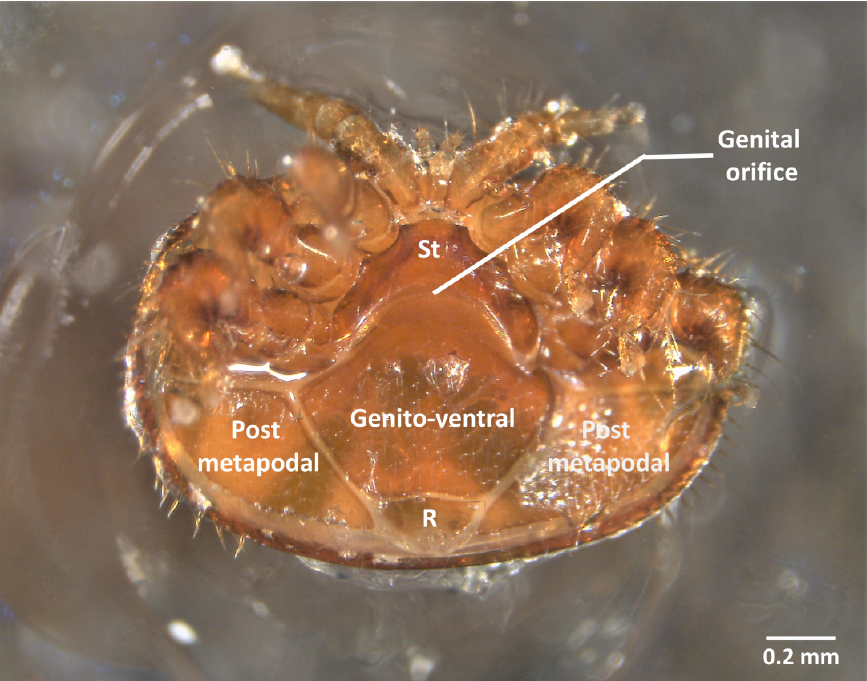
Figure 1. External view of a V. destructor female glued before ventral dissection (R = rectal scutum; St = sternal scutum).